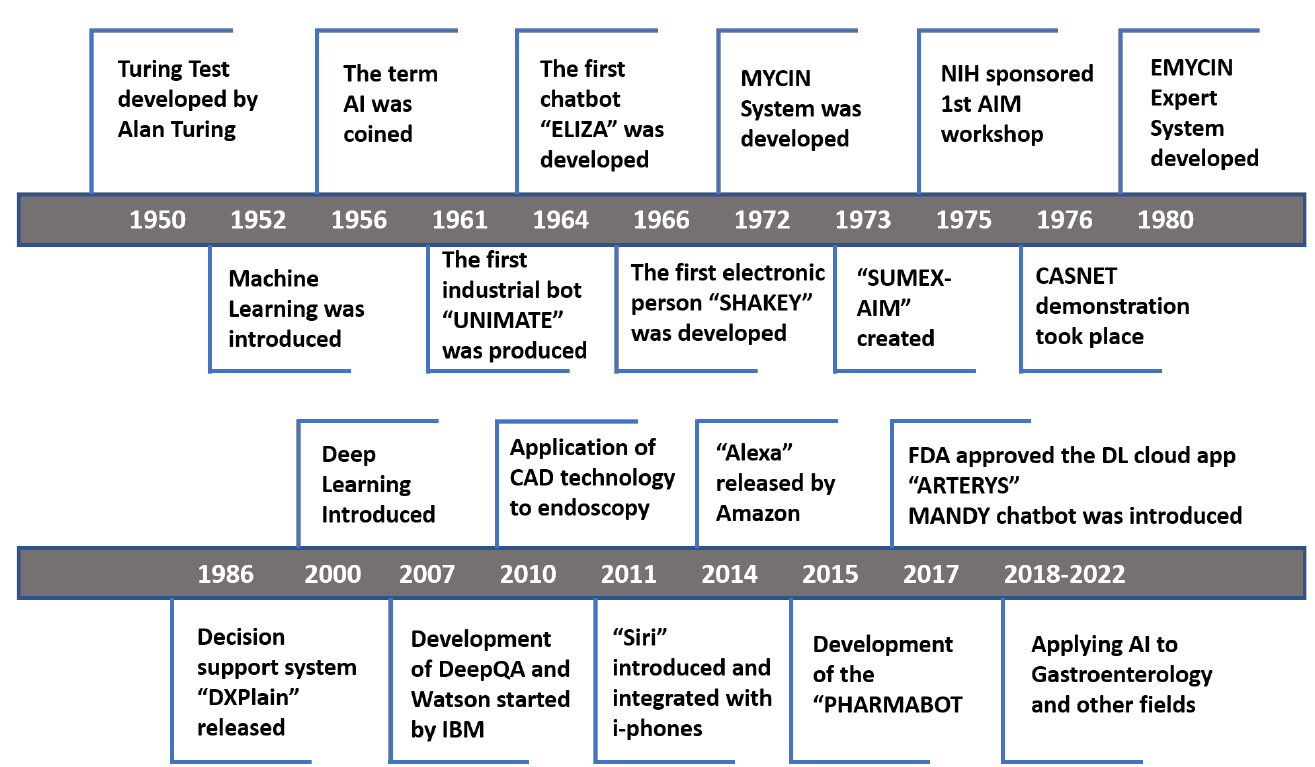
Figure 1. A Year-wise Evolution of AI in Healthcare (1950 – present).